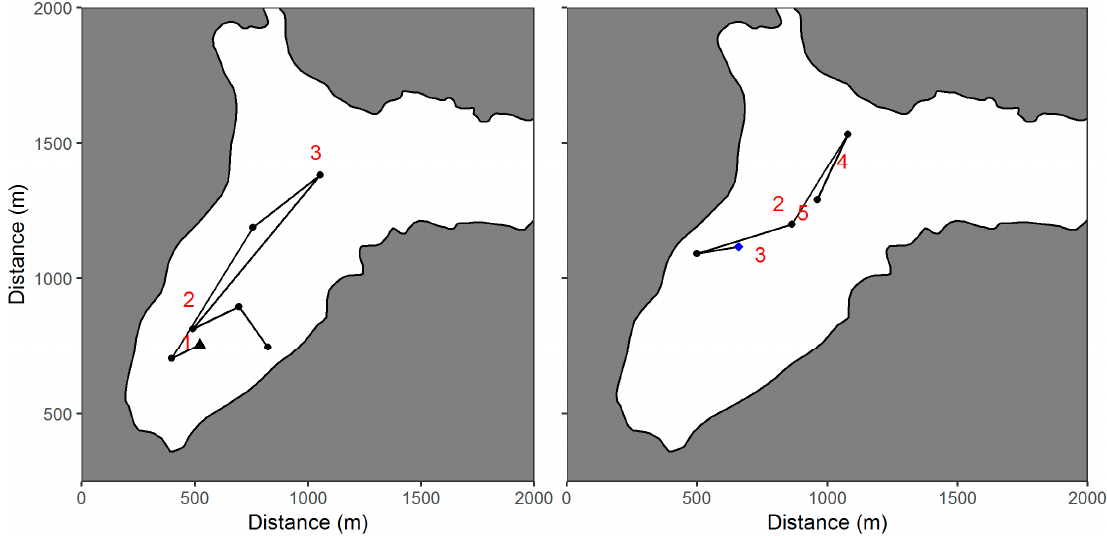
Figure 5. Comparison of the movement of Fish 12010 (left panel) and Fish 12004 (right panel) located using an autonomous underwater vehicle and vessel-based tracking in Big Port Walter, Alaska. The site where the fish were either released (black triangle) or first located for the fish released during a previous mission (blue diamond) are indicated. Subsequent AUV locations are represented by black dots. Vessel-based location estimates are designated by numbers that correspond to the sequential order of the paired AUV estimates (e.g., the numbers 2 and 4 correspond to the second and fourth AUV location).